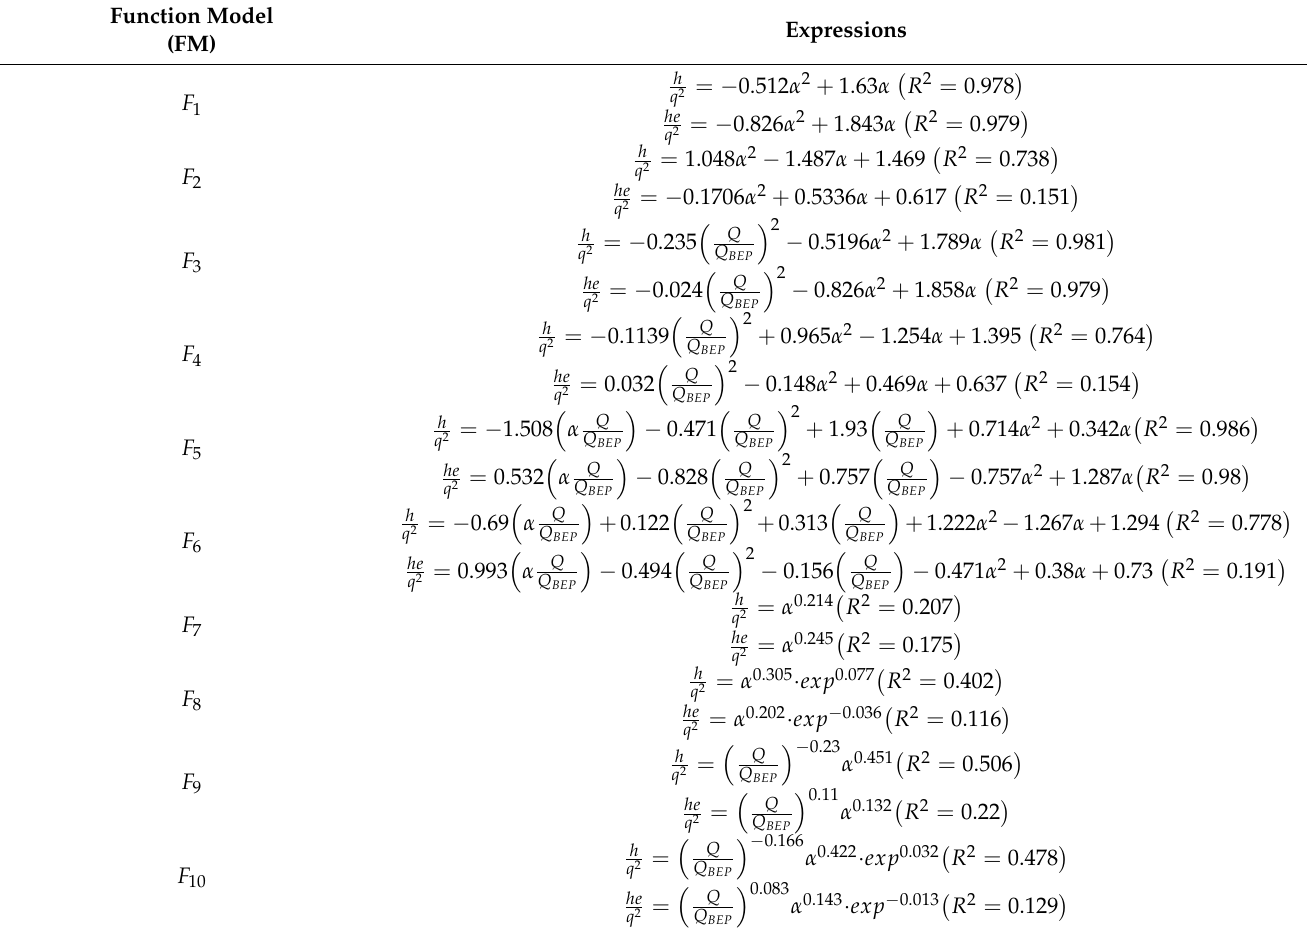
Table 5. Proposed expression for the dimensionless numbers.